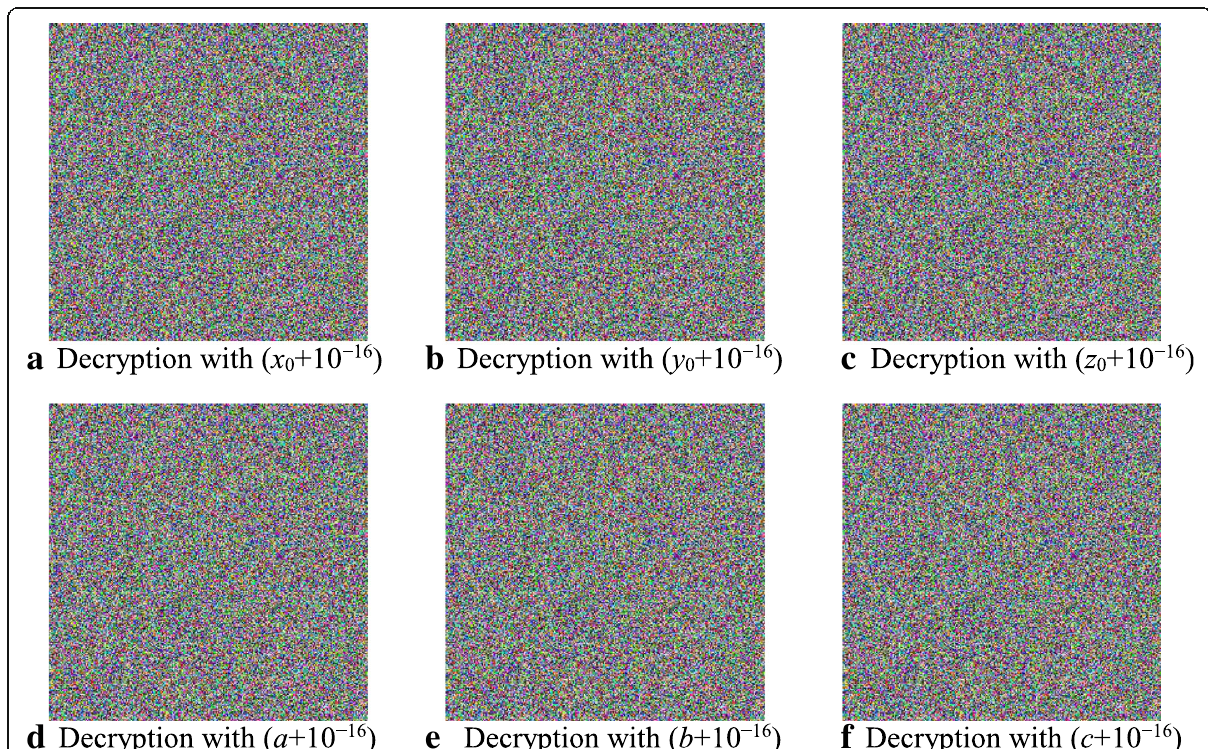
Fig. 4 Key sensitivity test results. a Decryption with ( x 0 + 10 − 16 ); b decryption with ( y 0 + 10 − 16 ); c decryption with ( z 0 + 10 − 16 ); d decryption with